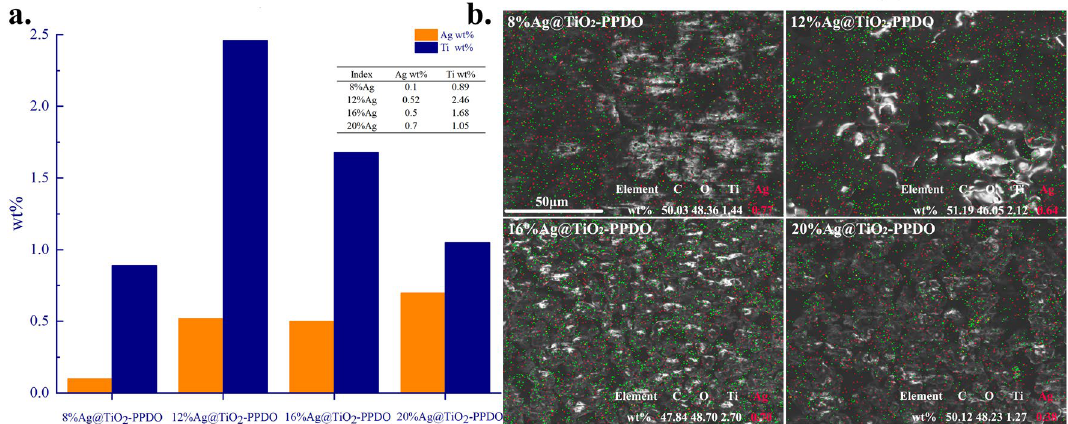
Figure 3. ( a ) Ag content detected by ICP; ( b ) SEM–EDS mapping of Ag@TiO 2 proportions of inorganic phase in Ag@TiO 2 -PPDOs 40,41 . Because Ag@TiO 2 nanoparticles grafted without or with inadequate PPDO segments were centrifugally discarded during the purification process of Ag@TiO 2 -PPDOs, grafting efficiencies would be increased with the final proportions of inorganic compounds in these composites. As illustrated in Fig. 2c,d, the grafting efficiency of 12% Ag@TiO 2 was the highest. As Ag was embedded embed- ded into the crystal defects of TiO 2 as determined by XRD or possibly present island pattern on the surface of TiO 2 nanoparticles as shown in Fig. 2b, the quantities of hydroxyl groups on the surface of TiO 2 nanoparticles would decrease 24 . Subsequently, hydroxyl groups on the surface of TiO 2 nanoparticles decreased with an increase in the Ag content loaded in TiO 2 nanoparticles. Hydroxyl groups on the surface of TiO 2 nanoparticles functioned as initiator to initiate the polymerization of PDO monomers; in other words, hydroxyl groups were the active growth center of PPDO segments 42 . As the active growth center decreases, PPDO grafting density decreases with the quantities of hydroxyl groups. In addition, as the feed molar ratio of PDO to TiO 2 nanoparticles is fixed, the average segmental length increases with decreasing hydroxyl groups. Then, as illustrated in Fig. 2e, although PPDO grafting density decreases with Ag content in TiO 2 , the average length of PPDO segments increases with Ag content in TiO 2 . However, both the extremely low grafting density and relatively short average length